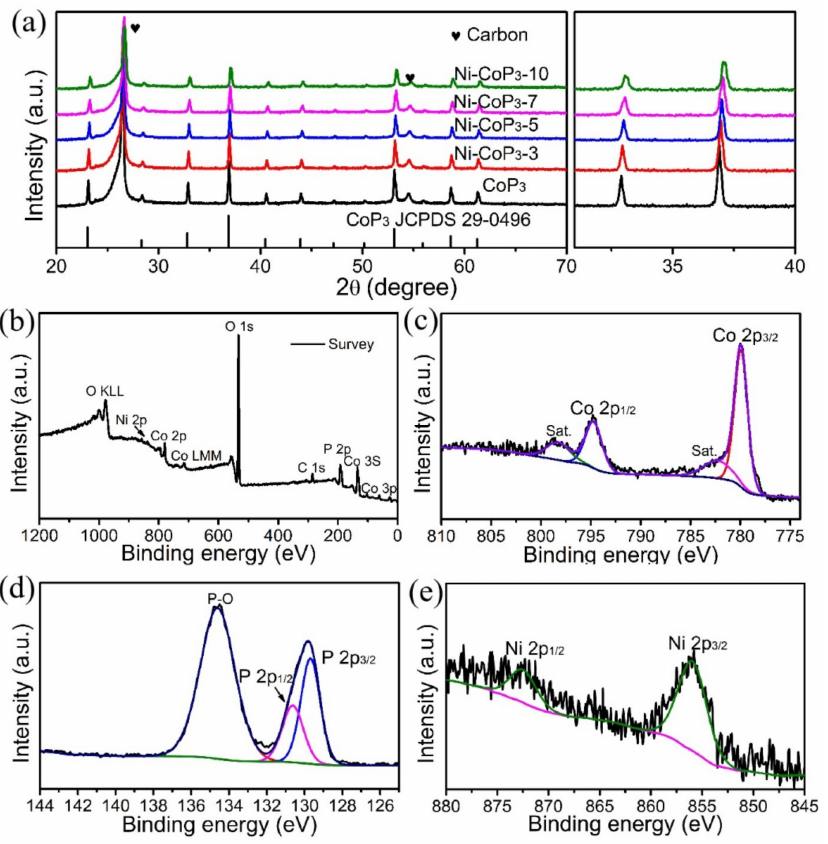
Figure 3. ( a ) XRD patterns and XPS ( b ) survey, ( c ) Co 2 p , ( d ) P 2 p , and ( e ) Ni 2 p spectra of Ni-CoP 3 -7 NWAs/CC